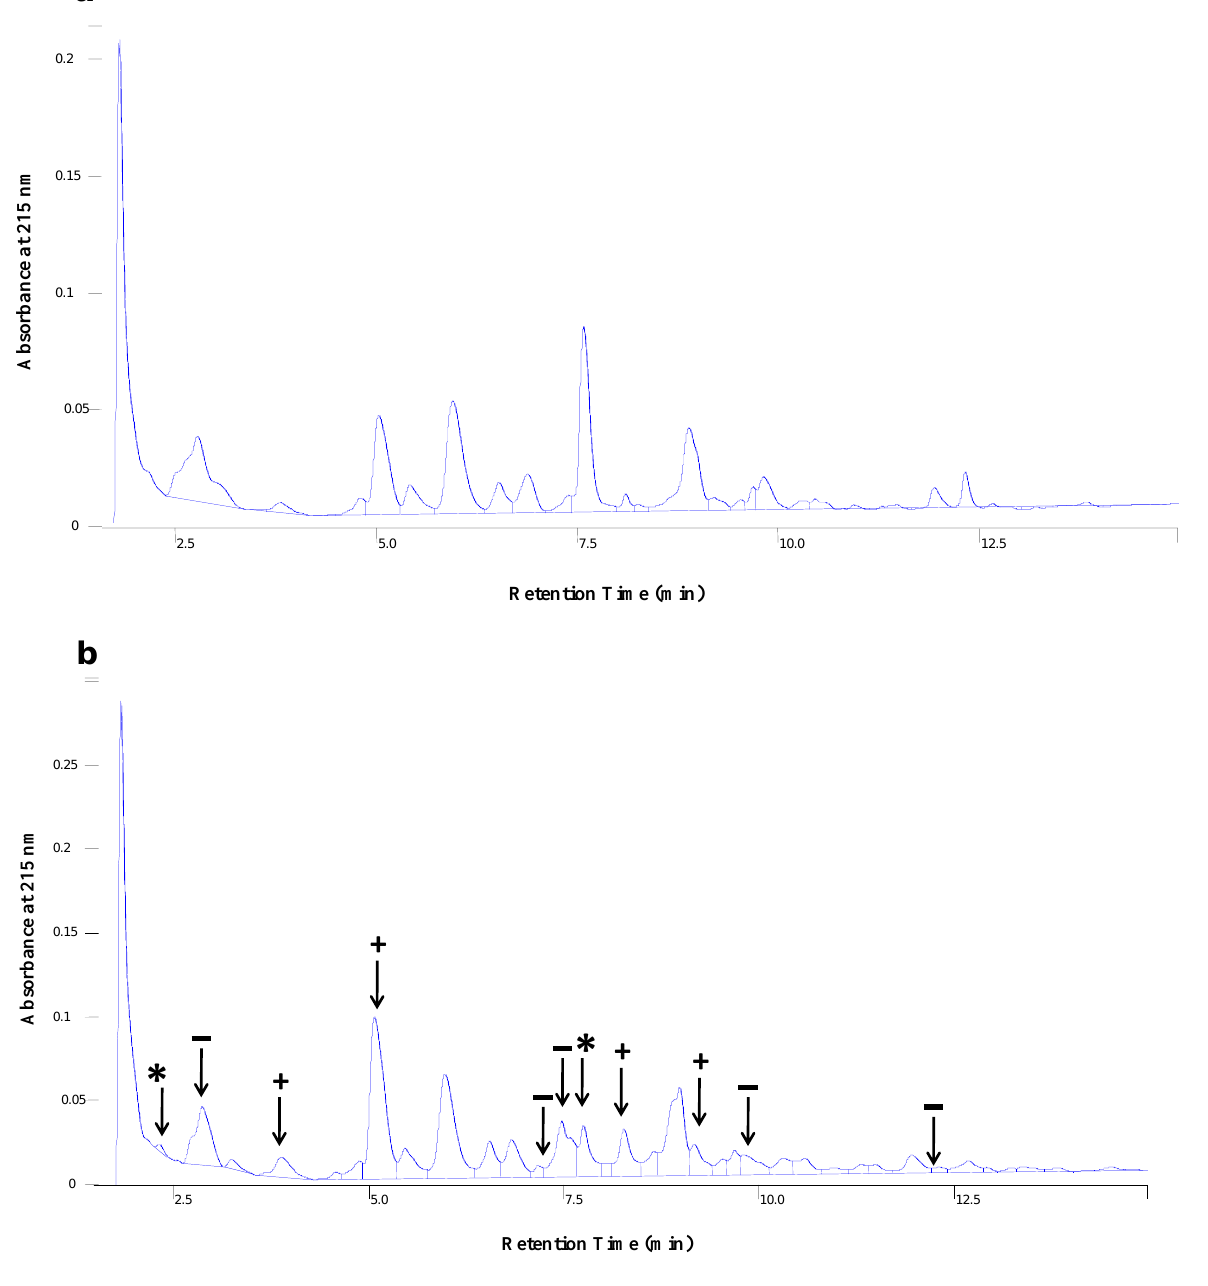
Figure 4. HPLC profiles of peptide extracts with MWCO ≤ 1 kDa derived from pepsin, trypsin, chymotrypsin and peptidase hydrolysis of: ( a ) nWPH and ( b ) pWPH. The arrows identify extra peaks found in pWPH hydrolysates (*) and indicate differences in the relative abundances of peptides as a result of pressure treatment (+, higher abundance, −, lower abundance in pWPH relative to